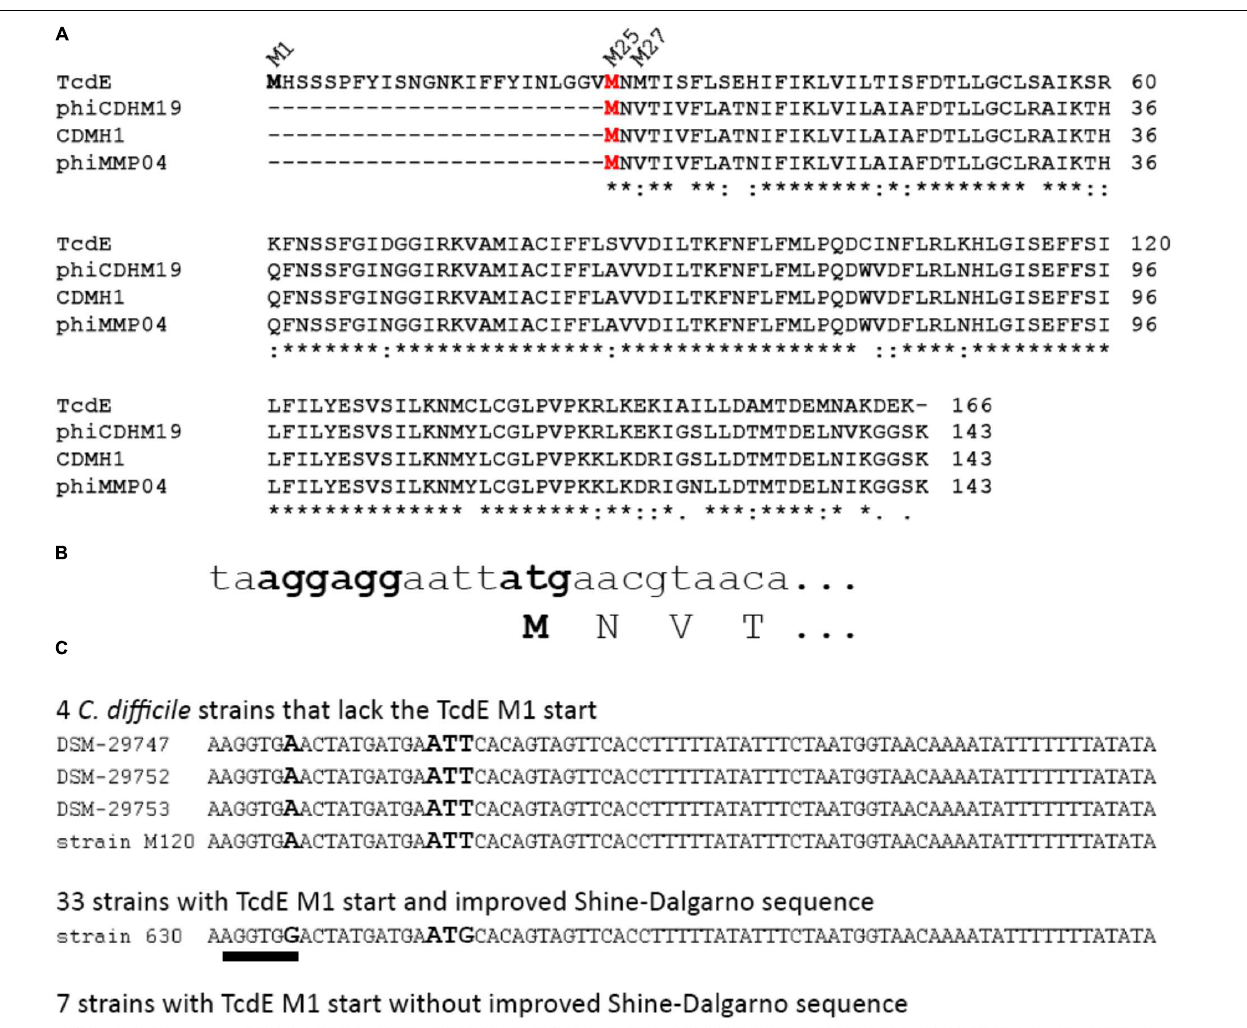
FIGURE 4 | The N-terminal extension of TcdE evolved within clostridia. (A) Comparison of the N-terminal sequence of TcdE with that of the three most closely related TcdE homologs from C. difficile phages. Note that the M1 and M27 isoforms are lacking in the phages, and only M25 (red) is conserved in all cases. “ ∗ ” indicates identical positions, “ : ” positions with highly similar exchanges, “ . ” positions with weakly similar exchanges; (B) DNA sequence of the translational start region in all three phage tcdE homologs. Note that the Val codon that corresponds to the M27 in TcdE is not the rare initiation codon GTG, but rather the valine codon GTA. (C) DNA sequence comparison that shows the lack of the standard M1 translational start for TcdE in four of the analyzed C. difficile strains, and a less efficient ribosomal binding site in these four cases and in further seven strains, with DSM 27640 as example. The corresponding sequence of strain 630 is given as example for the 33 analyzed strains that possess a canonical M1 translational start with a good Shine-Dalgarno sequence. The improved Shine-Dalgarno sequence is underlined. Bold letters indicate the variable position in the Shine-Dalgarno sequence and the position of the M1 start codon.